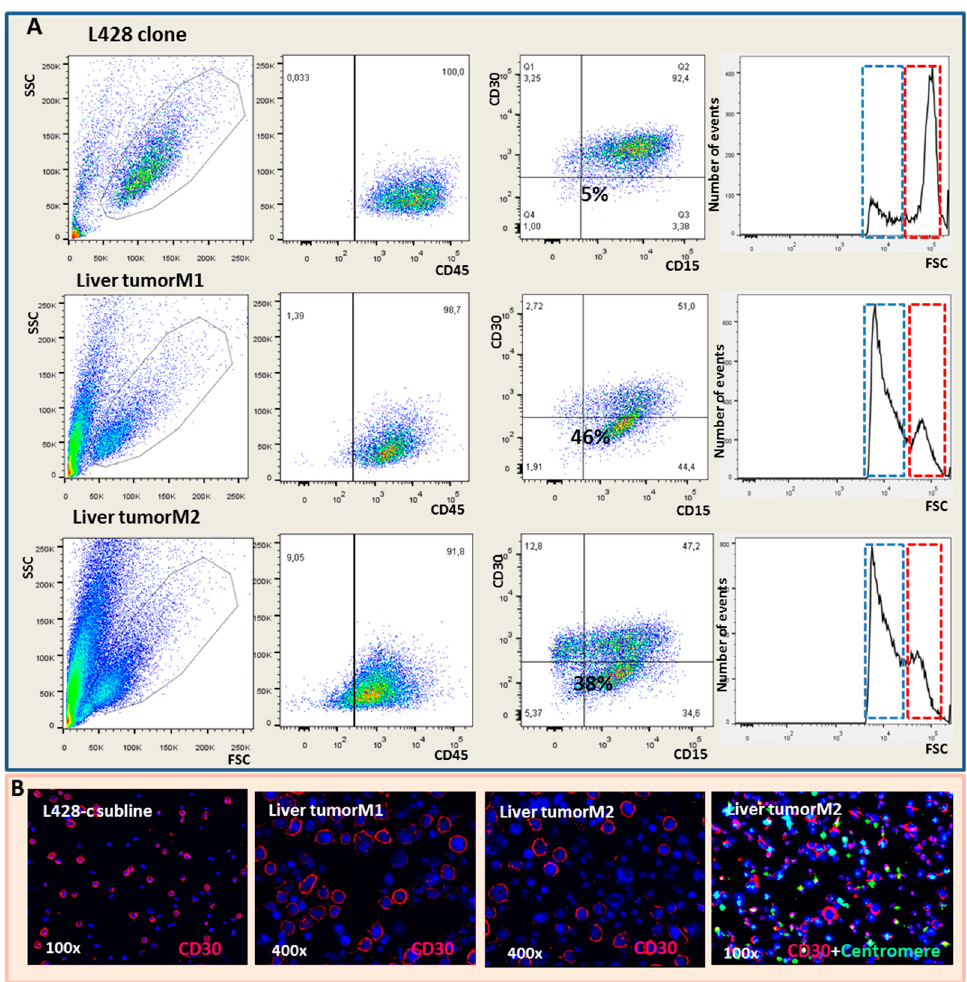
Figure 4. Analysis of the cells recovered from liver tumors of two mice (M1 and M2) 32 weeks after injection of 103 L428-c cells by flow cytometry, immunofluorescence microscopy, and human centromere staining. ( A ) flow cytometry analysis of liver tumor cells was performed using the surface marker CD45 to select for human cells and CD15/CD30 as specific markers for HL. The proportion of each sub-population with respect to CD30 and CD15 marker levels is presented. The FSC demonstrates the presence of two cell populations, in both the injected cells and in the liver tumor cells, although at different frequencies. The red box shows the mean FSC of injected cells and the blue box the mean FSC of HL cells recovered from liver tumors of NSG mice. Liver tumor cells contained a higher proportion of CD30 − /CD15 − cells (5% and 2% vs. 1% for L428-c and 2% for mouse 1) and CD30 − (46% (M1) and 40% (M2) vs. 5% for L428-c). ( B ) Immunofluorescence staining for CD30, showing the presence of cells without CD30 staining in the L428-c subline and mouse liver tumors One of the panels shows immuno-FISH specific for CD30 and for human centromere sequences confirming the presence of a small population of CD30 negative human cells with a high intensity of centromere sequences in a mouse liver. HRS cells were CD30 positive and showed positive FISH signals specific for centromeres sequences.